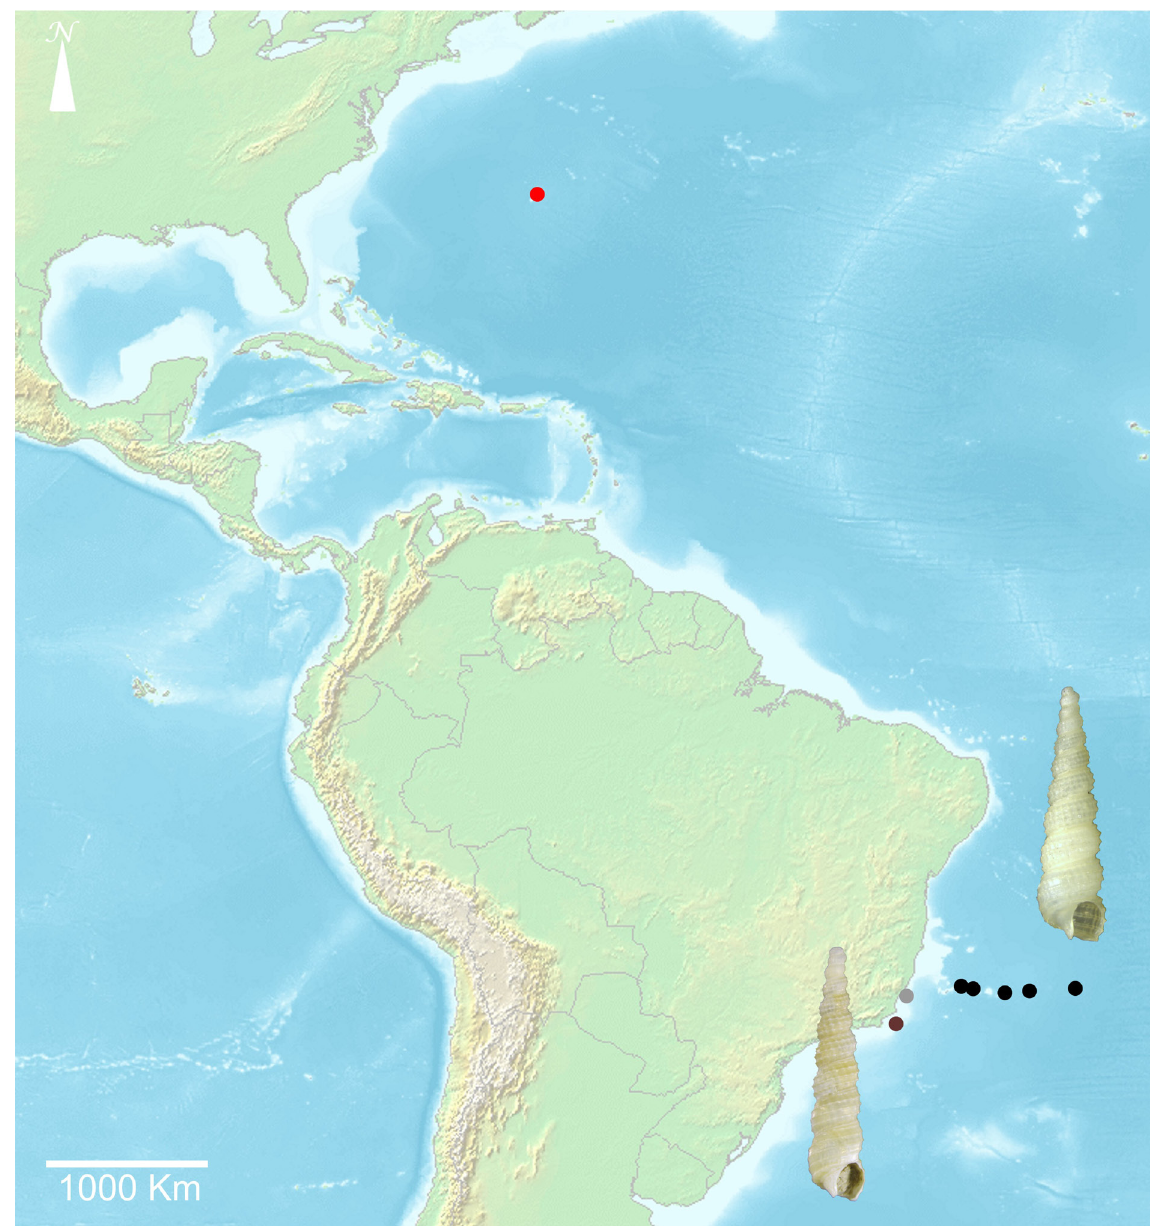
Fig. 28. Distribution map of Metaxia prompta Rolán & Fernández-Garcés, 2008 (red circle = type locality; black circles = additional localities) and Metaxia gongyloskymnus Fernandes & Pimenta, 2011 (brown circle = type locality; gray circle = additional